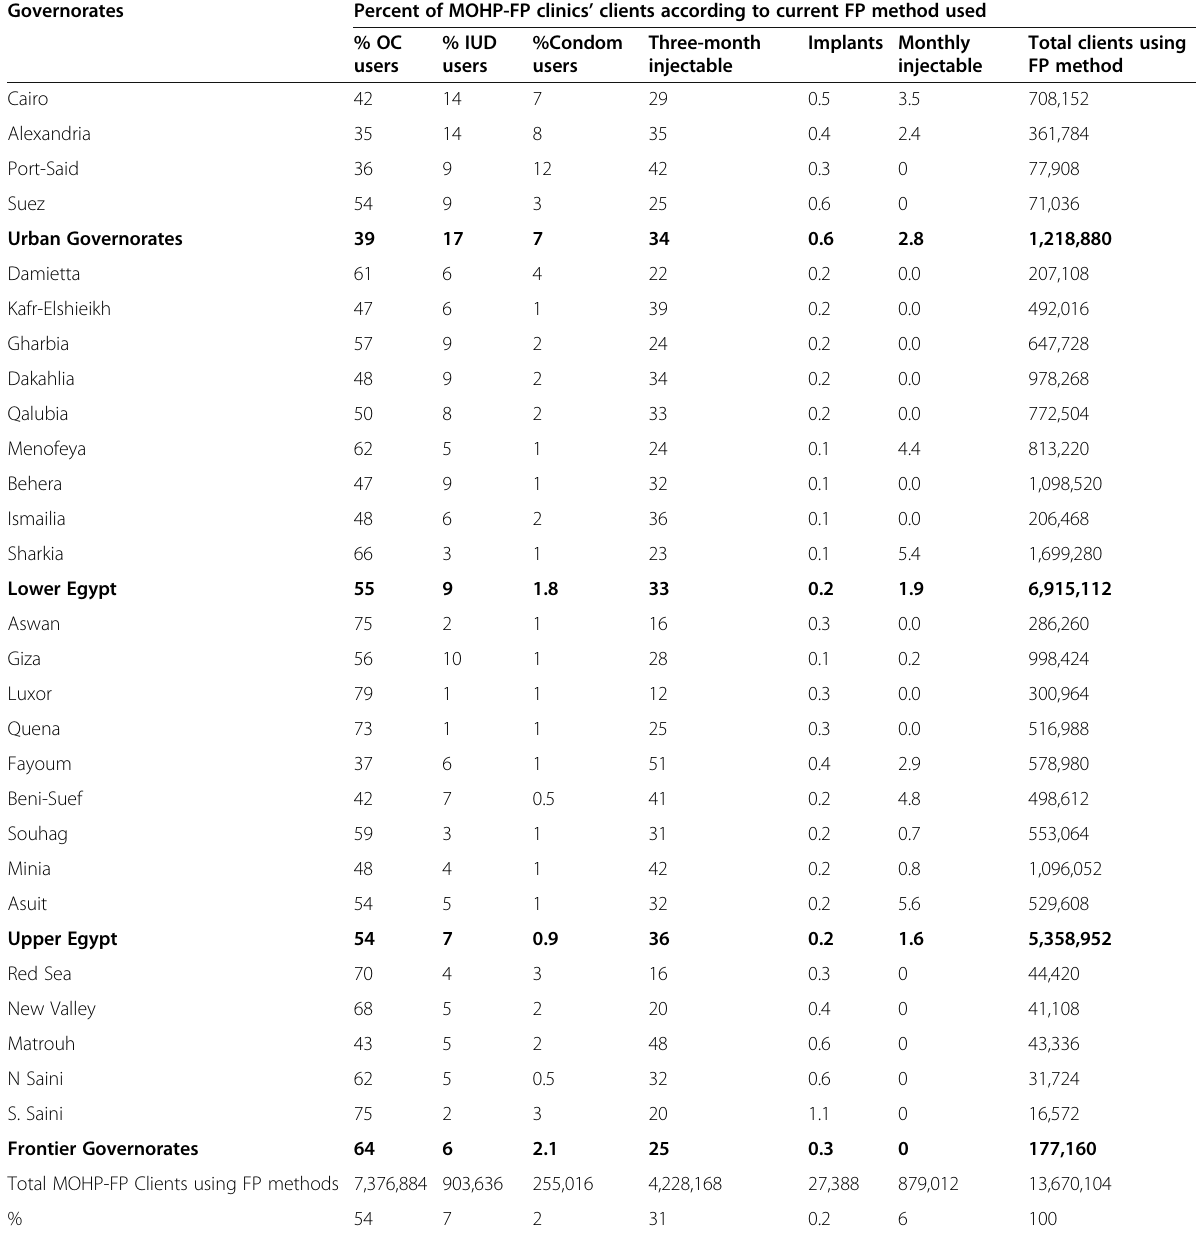
Table 3 Distribution MOHP-FP clinics ’ clients who were currently using contraceptive methods by type of the method, governorate and region, Egypt, 2014